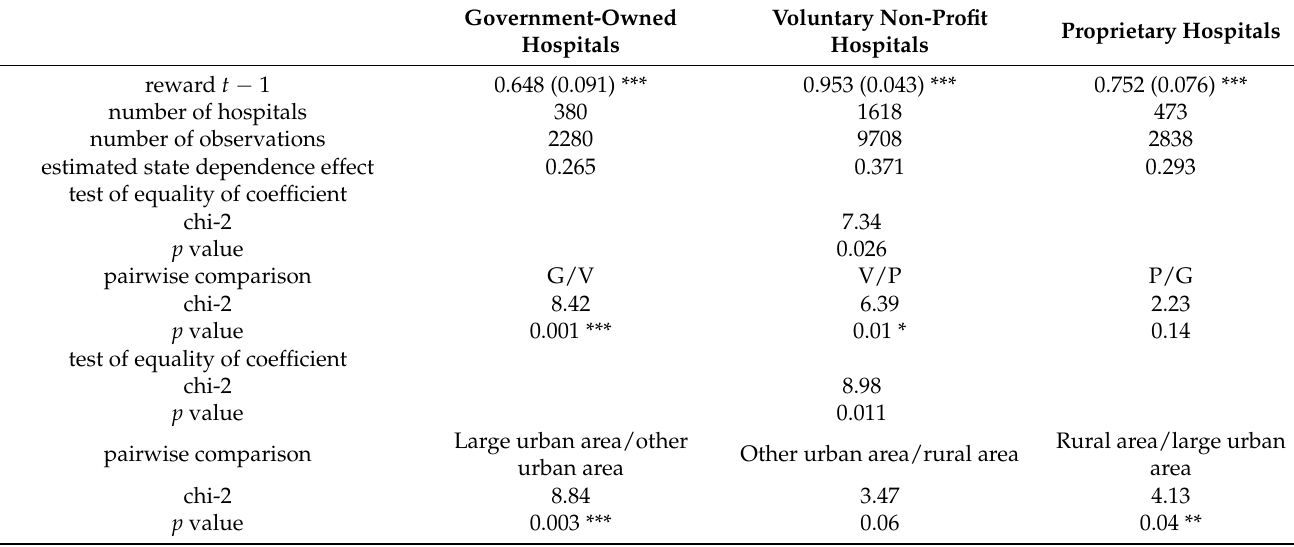
Table 9. Comparison of state dependence effect across different ownership.